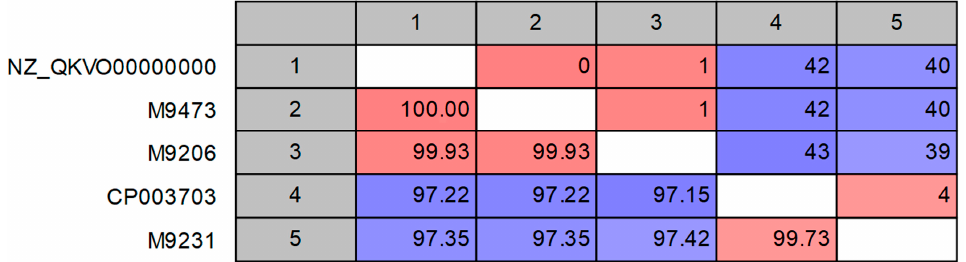
Figure 2. Pairwise comparison of the complete 16S gene of the three Mycoplasma isolates M9473, M9206 and M9231 characterised in the present study and the 16S gene of the strains INIFAP02 (NZ_QKVO00000000) and Massachusetts (CP003703). Above the diagonal, the numbers of differences are shown and below the diagonal the percentage identity. Red and blue colour indicate high (<12 differences; >99.5% identity) and low (>24 differences; <98.1% identity) similarity, respectively.